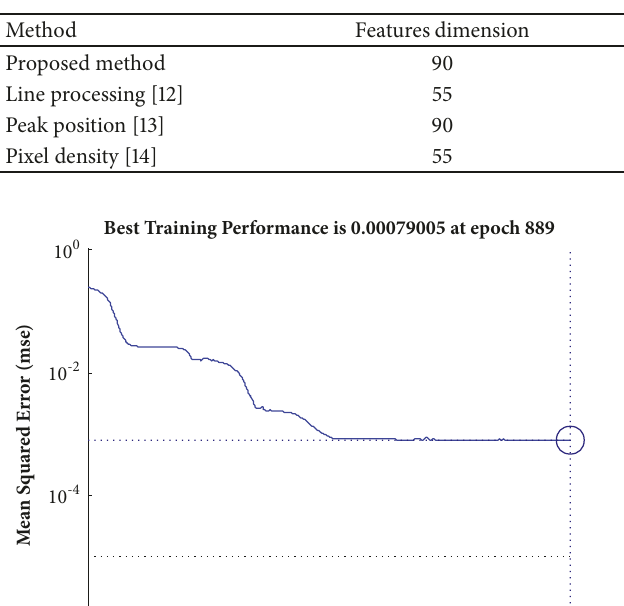
Table 2: Comparison of the proposed method and conventional methods on three factors.